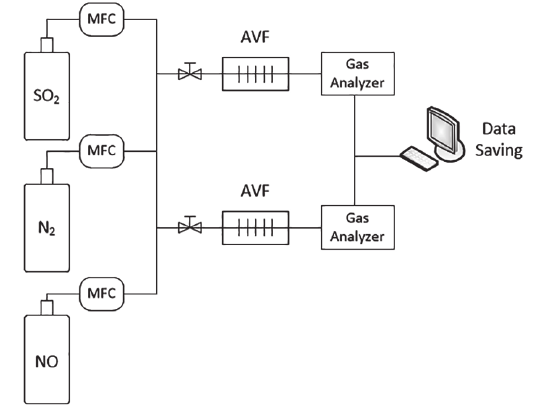
Figure 2 - Experimental system for removal of SO NO gases by